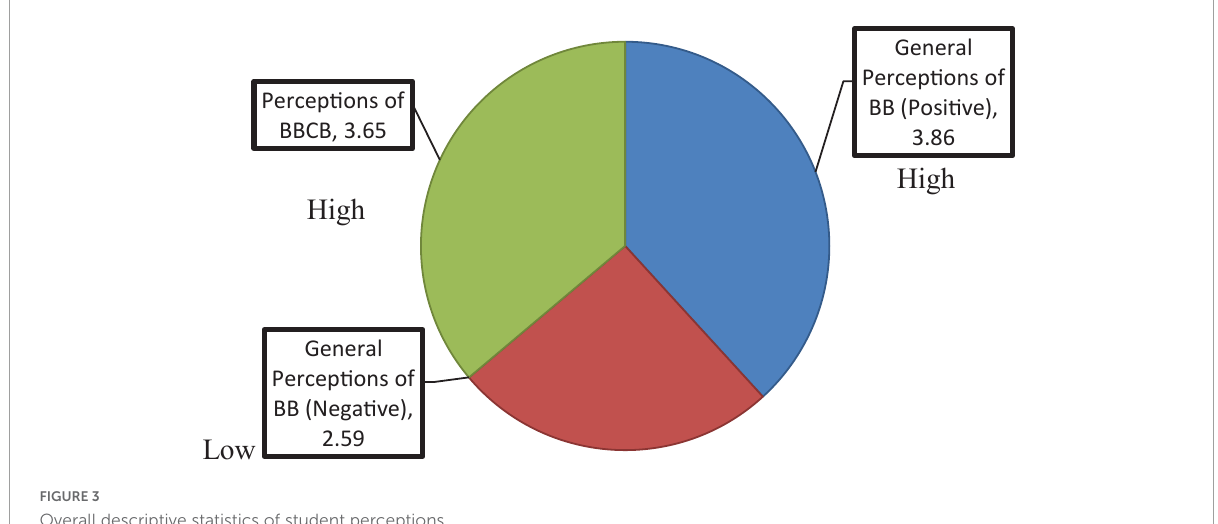
FIGURE3 Overall descriptive statistics of student perceptions.